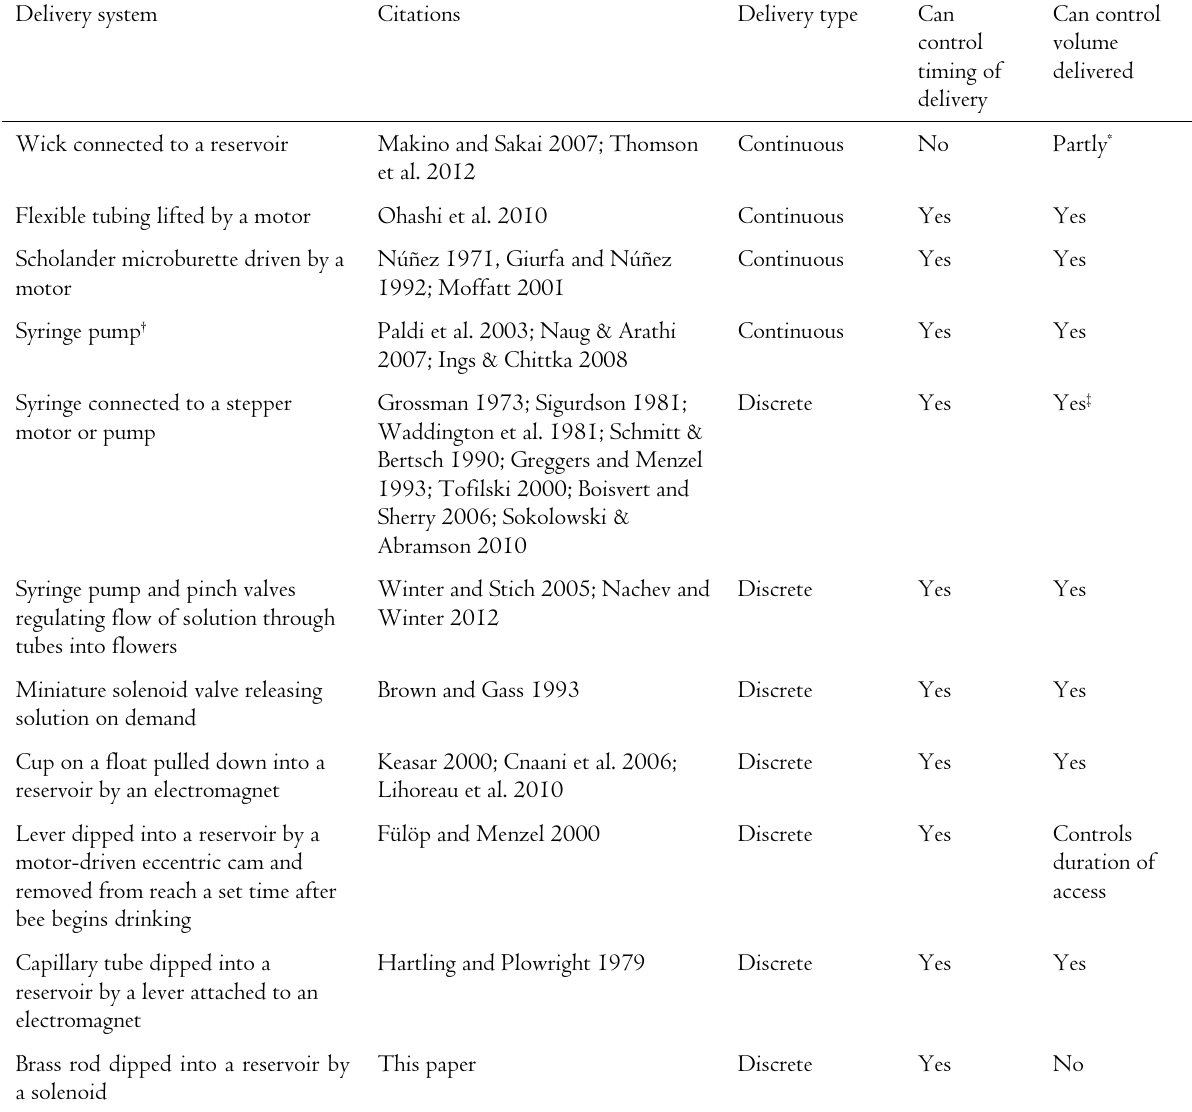
Table 1. Summary of artificial flower designs capable of automatic